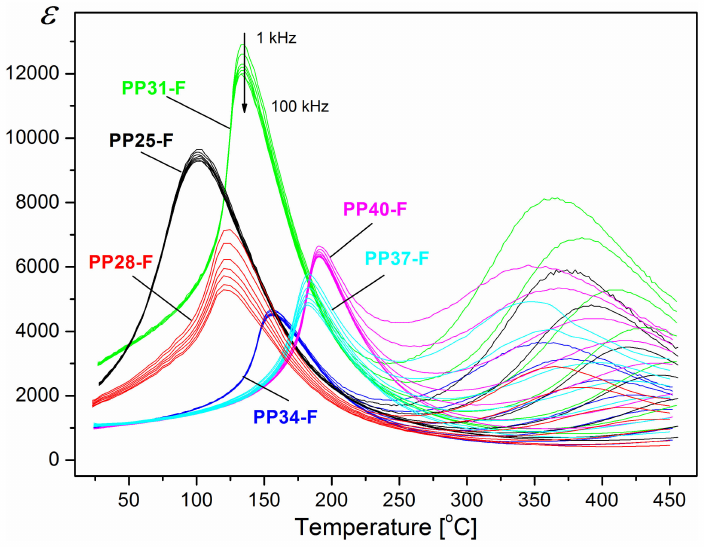
Figure 4. Temperature dependencies of dielectric permittivity ε for the PP-F ceramic composites (heating cycle, frequency: 1 kHz, 2 kHz, 5 kHz, 10 kHz, 20 kHz, 50 kHz, 100